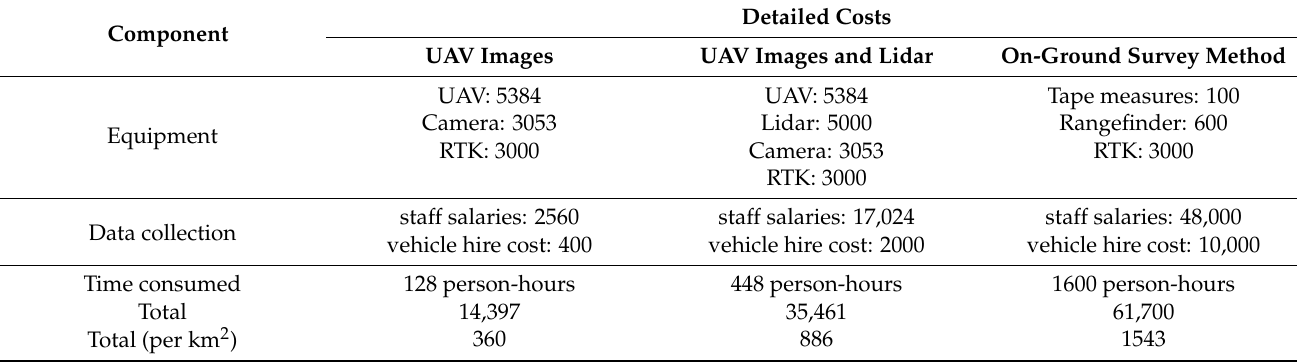
Table 6. Detailed costs and total costs of three different methods used for mapping the plucking area of a 10 km 2 tea plantation four times (unit: